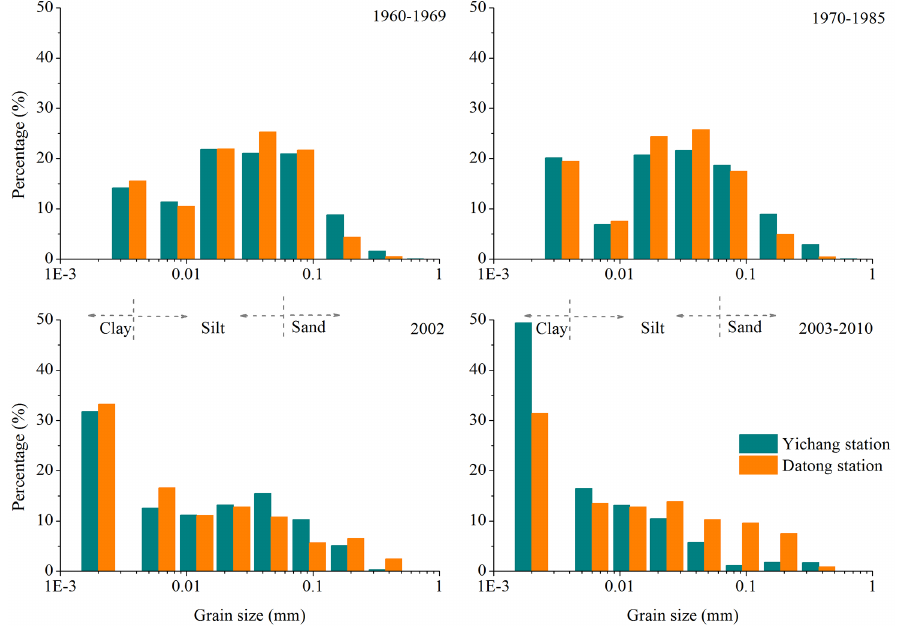
Figure 7. Distribution of the suspended sediment grain size of the Yichang and Datong stations in 1960–1969, 1970–1985, 2002 and 2003–